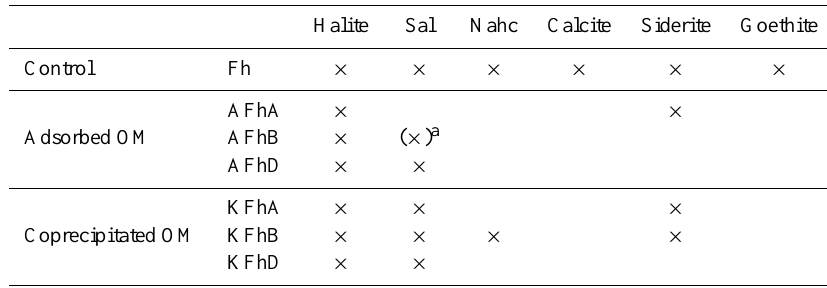
Table 2. Mineral identification by XRD after reduction by G. bremensis . Sal ammoniac (NH 4 Cl) is abbreviated by “sal”, nahcolite (NaHCO 3 ) by “nahc”.